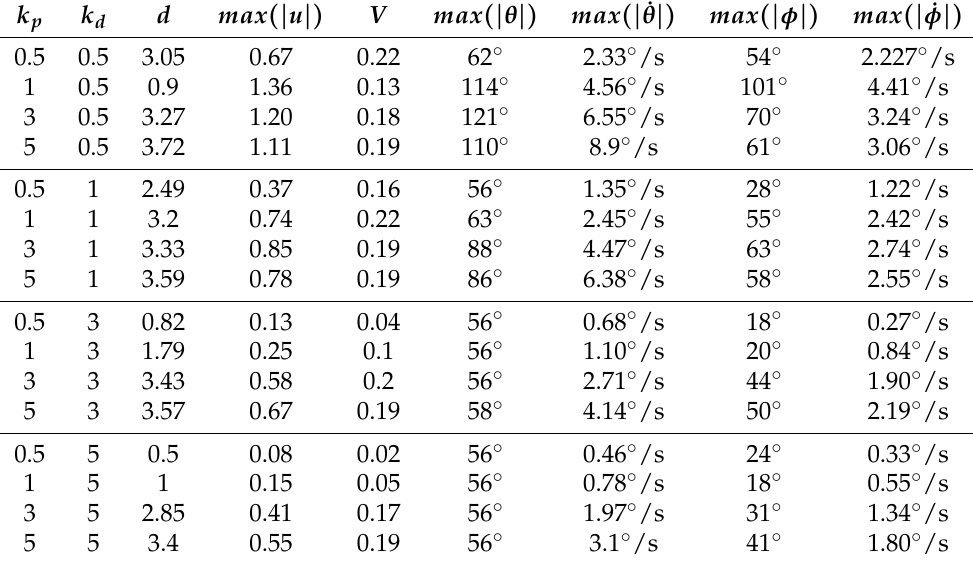
Table 4. Simulation results for different control